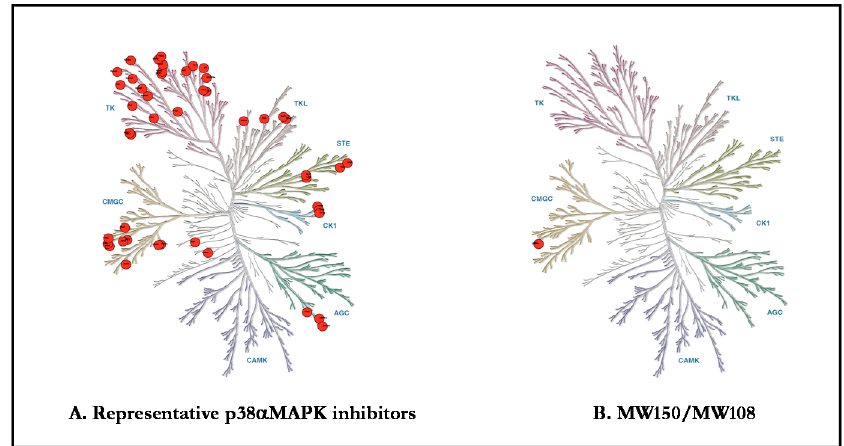
Figure 2. Kinome target selectivity of p38 MAPK Inhibitors. Differences in off-target kinase and GPCR liabilities provide potential explanations for pharmacological differences. Red circles denote kinase inhibition below the canonical IC50 < 1 μ M. ( A ) Common off-target kinases among widely used p38 α MAPK inhibitors: VX-745 (neflamapimod) includes ABL1, ABL2, p38 β , PDGFR β , and SRC; BIRB-796 includes BLK, CDK5, CDK8, DDR1, DDR2, EPHA3, EPHA7, EPHA8, EPHB2, p38 β p38 γ , FLT1, FRK, NTRK1, JNK1, JNK2, JNK3, KIT, MAP4K4, MRCK β , PTK2 β , RET, SLK, STK10, TIE1, TIE2, TNIK, TRKB, TRKC, and ZAK; and SB203580 includes BRAF, CIT, CK1 δ , CK1 ε , DMPK, GAK, JNK2, JNK3, NLK, p38 β , RIPK2, STK36, and TNIK. ( B ) MW150 and MW108 have IC50 <1 μ M for p38 α MAPK in kinome-wide hierarchal screens.